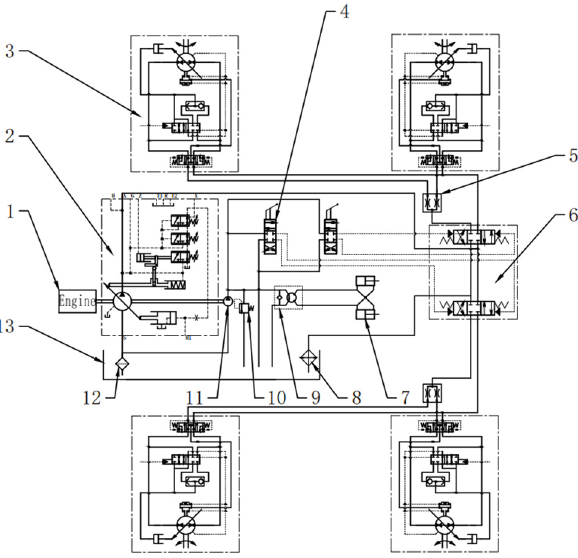
Figure 4. Hydraulic system schematic diagram. (1) Engine (2) Main pump (3) Hydraulic traveling motor (4) Foot valve (5) Gear shunt motor (6) Multi way directional valve (7) Steering cylinder (8) Radiator (9) Steering gear (10) Overflow valve (11) Pilot pump (12) Filter (13) Oil tank.